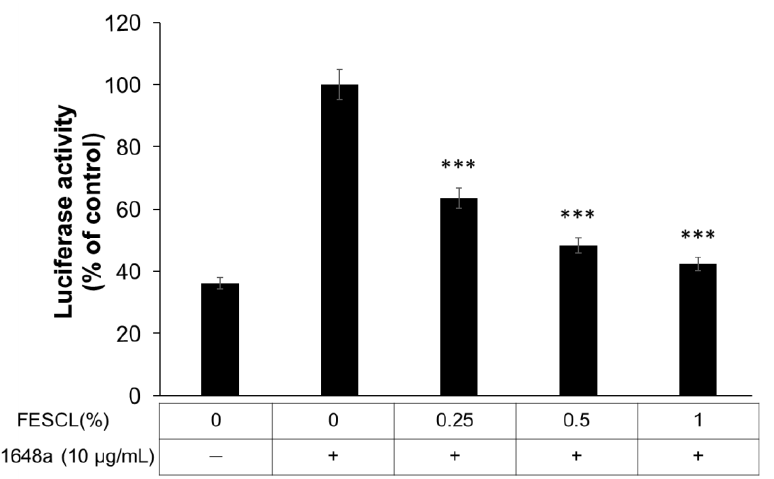
Figure 2. Luciferase activity of FESCL by the treatment of PM1648a (10 µ g/mL) in HaCaT cells. The data are presented as the mean ± SD of three replicates. *** p < 0.001 vs. the PM1648a treatment control group.